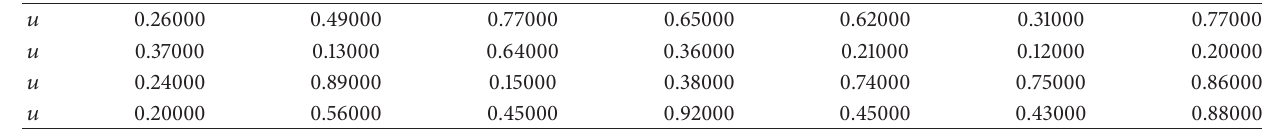
Table 1: The values of the parameters 𝑢 .